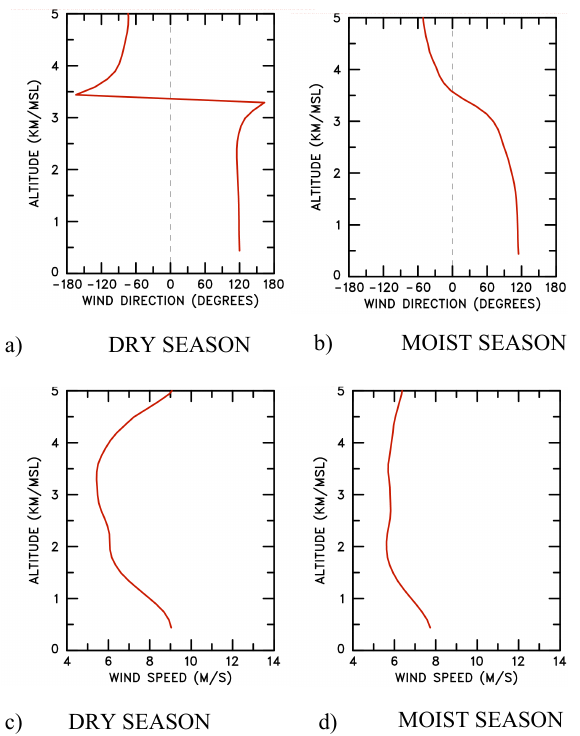
Fig. 5. As in Fig. 4, but for the mean wind direction (a, b) and Figure 5 : As in Fig. 4, but for the mean wind direction (a-b) and intensity (c-d). 692 intensity (c, d) during the dry season (a, c) and the moist season (b, d)